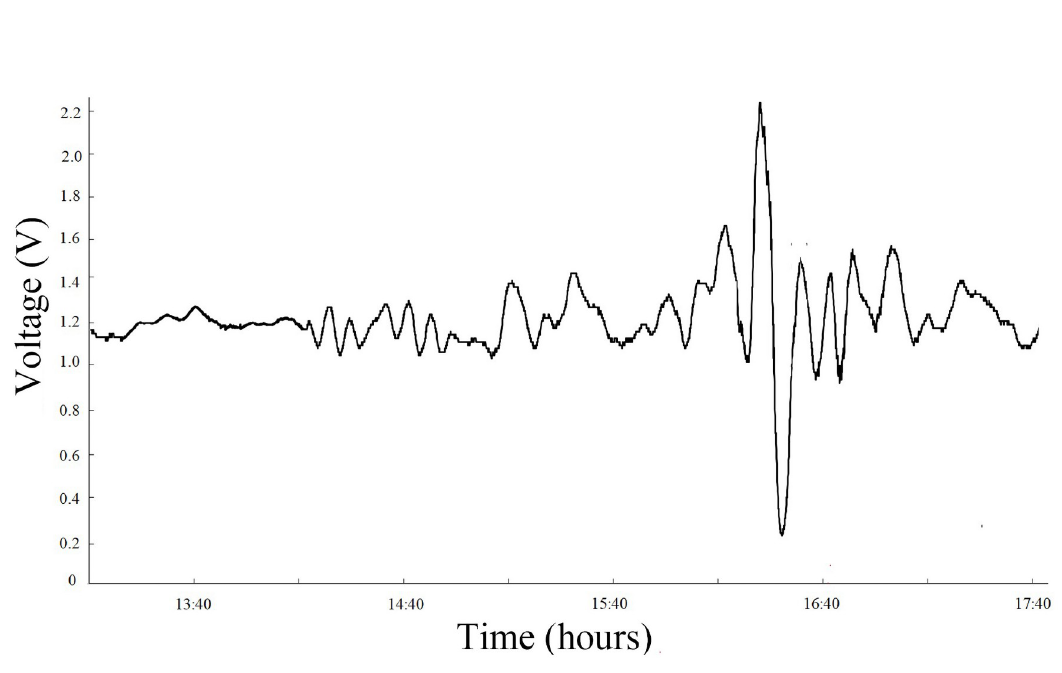
Fig 3. Anomalous infrasound signals on September 18, 1999.